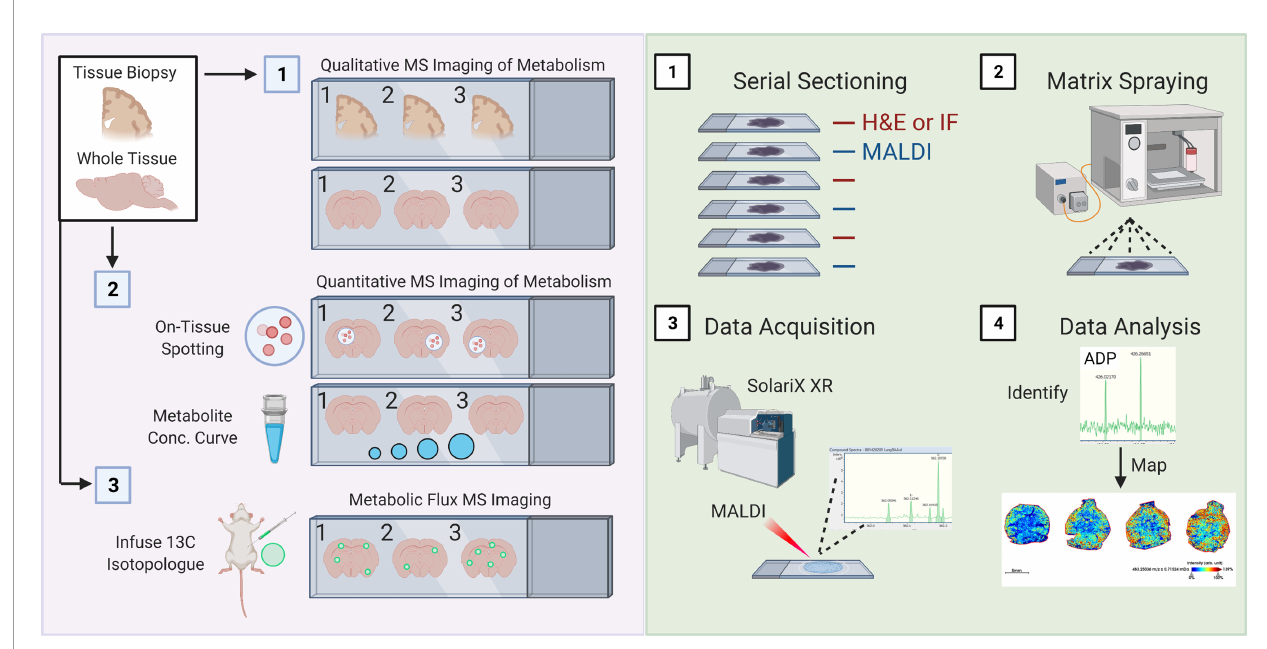
FIGURE 3 | Schematic of spatial metabolomic analysis using MALDI Mass Spectrometry imaging. (A) 1. Isolated whole or sectioned tissue can be analyzed using a combination of untargeted approaches involving various MALDI matrix substances, such as 9-AA, allowing for pro fi ling of a broad range of metabolite sizes and classes. 2. Quantitative analysis of metabolites of interest can be performed using two interconnected approaches: On-tissue spotting and metabolite concentration curves. On-tissue spotting involves taking a slurry of known metabolites (at known concentrations) and dabbing them onto tissues of interest. This allows for an internal reference standard to control for matrix deposition and laser excitation. Metabolite concentration curves allow for quanti fi cation of the concentration of a speci fi c metabolite or fi nite number of metabolites of interest. 2. Metabolic fl ux analysis can be performed by adopting conventional in vivo infusion of 13 C-labeled metabolites, such as uniformly-labeled 13 C-Glucose into mice. (B) 1. Samples are cut entirely into serial sections. Interleaved sections are used for MALDI or H&E/ immuno fl uorescence staining. 2. Slides used for MALDI are sprayed with matrix of interest using a standard MALDI matrix sprayer. Up to two slides can be sprayed and run at a given time, and slides with applied matrix should be imaged immediately. 3. Slides are then analyzed using a MALDI MSI (such as the SolariX XR MALDI-FT-ICR instrument, pictured). Slides are analyzed at a desired pixel resolution within the limits of the machine (e.g., 20-micron), meaning that the MALDI laser is rastered over the whole tissue surface, exciting 20-micron regions at a time. 4) Mass spectrometry peaks are subsequently analyzed for identity (see method) and mapped back onto H&E or IF stained